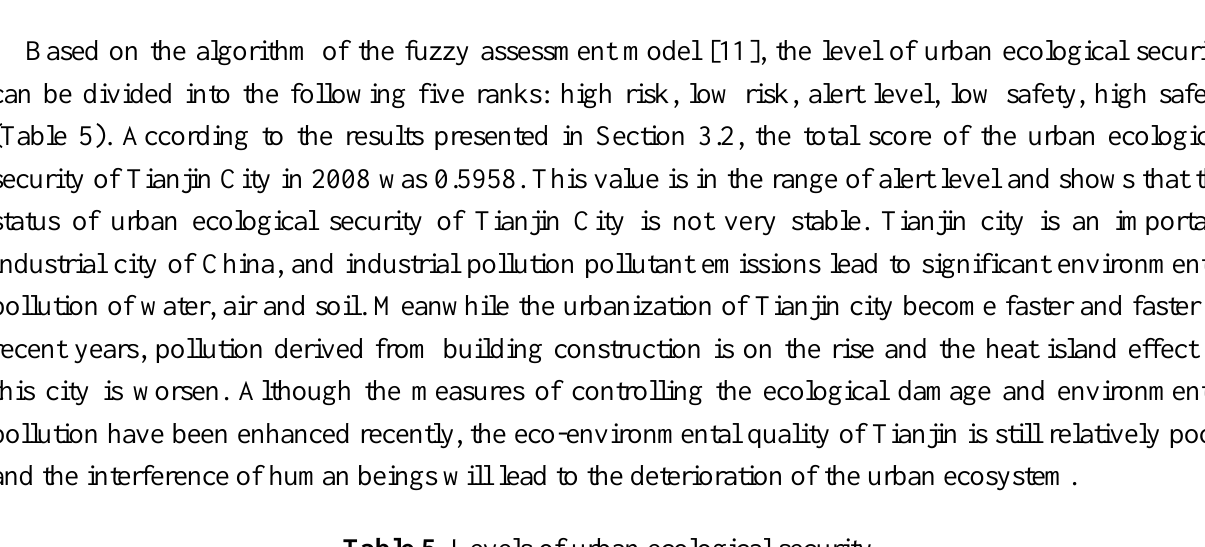
Table 5. Levels of urban ecological